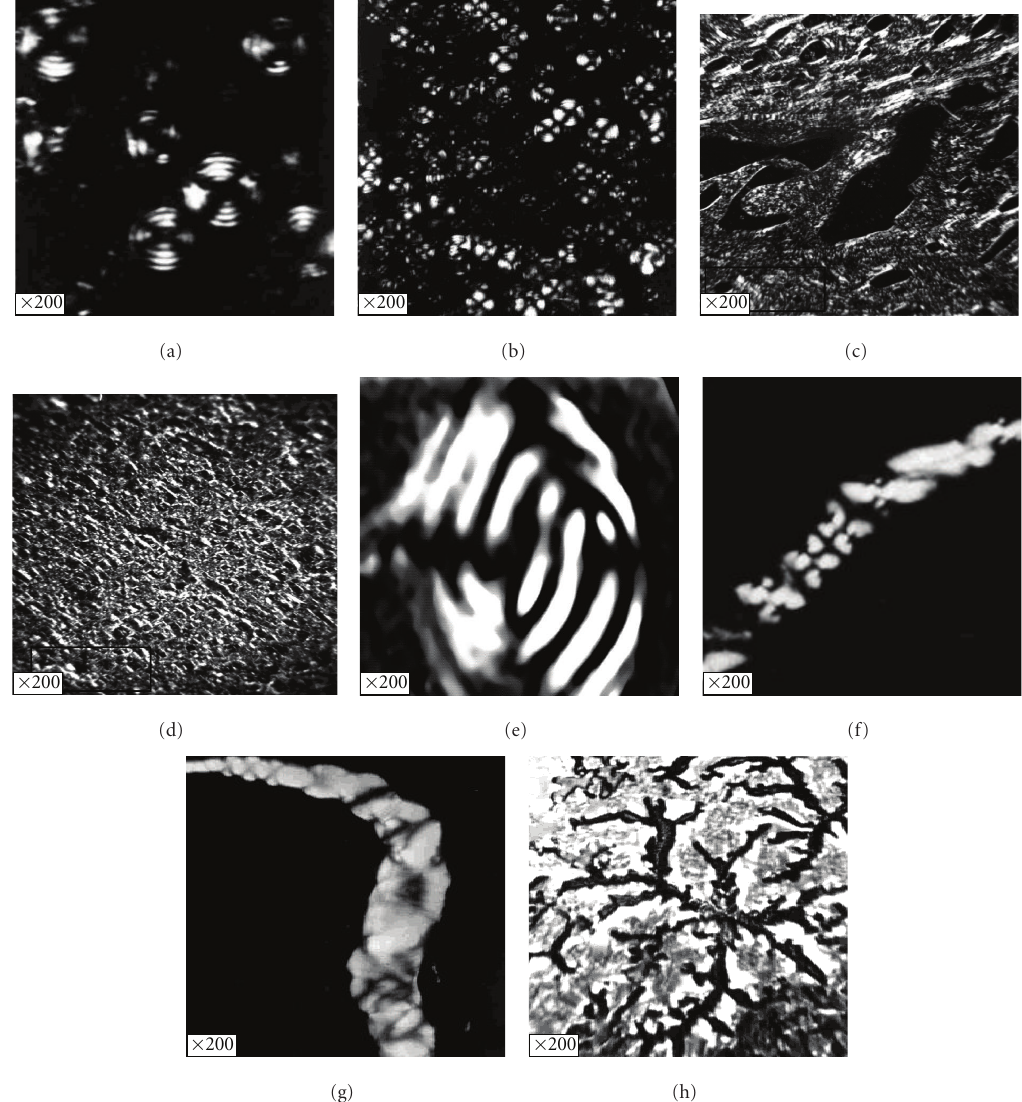
Figure 6: Microphotographs of the structures arising in aqueous solutions of CAS at 20 ◦